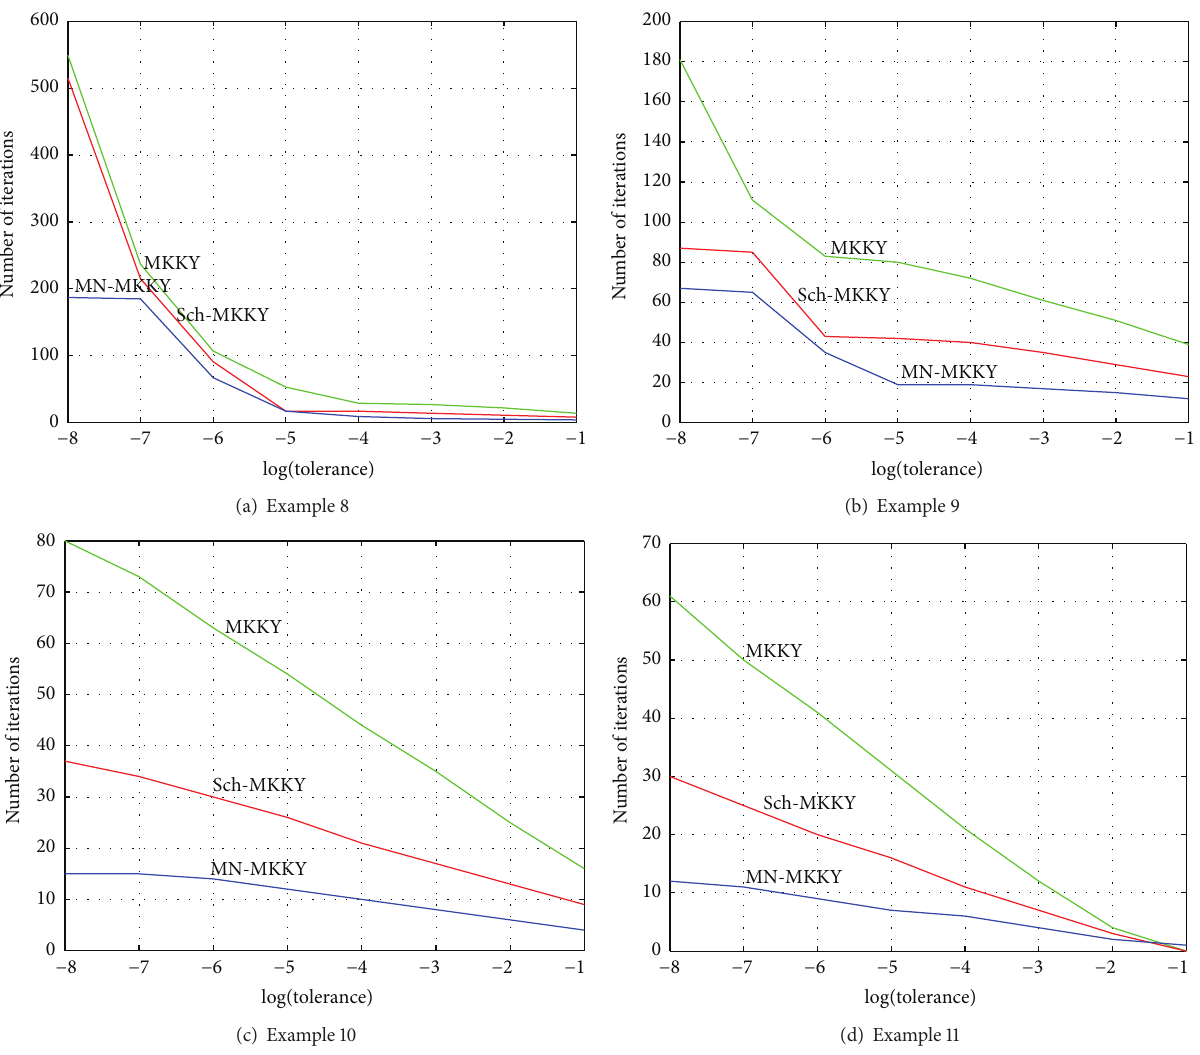
Figure 1: The tolerances against number of iterations are compared for MKKY, Sch-MKKY, and MN-MKKY algorithms for Examples 8, 9, 10, and